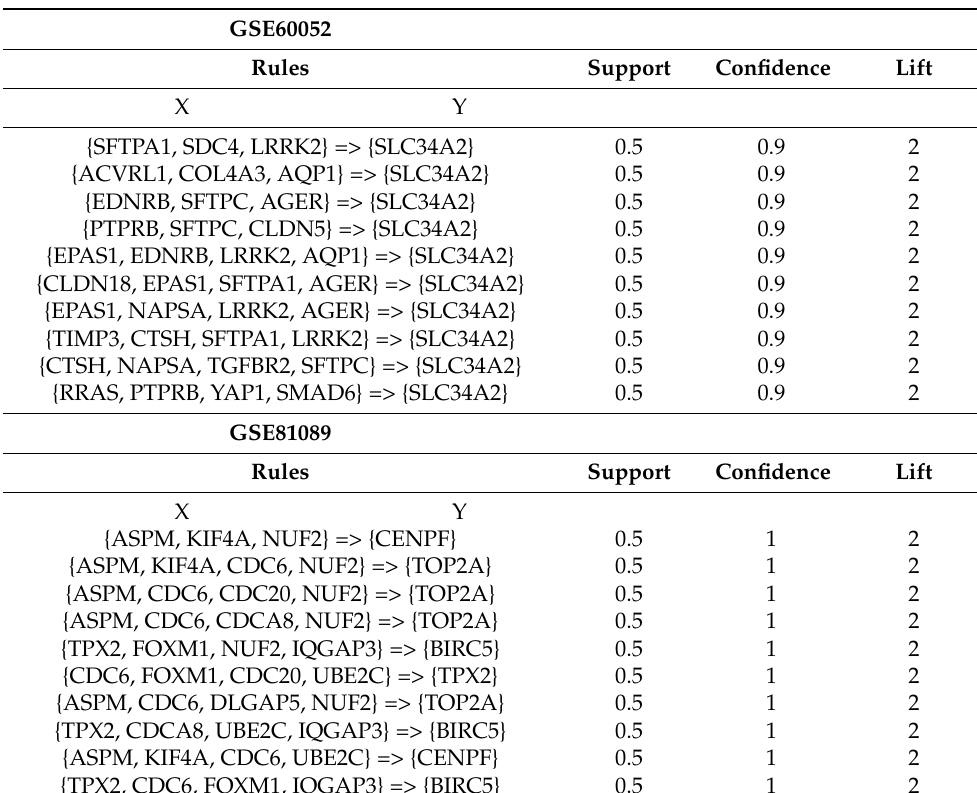
Table 5. A summary of top ten rules generated from the two datasets after